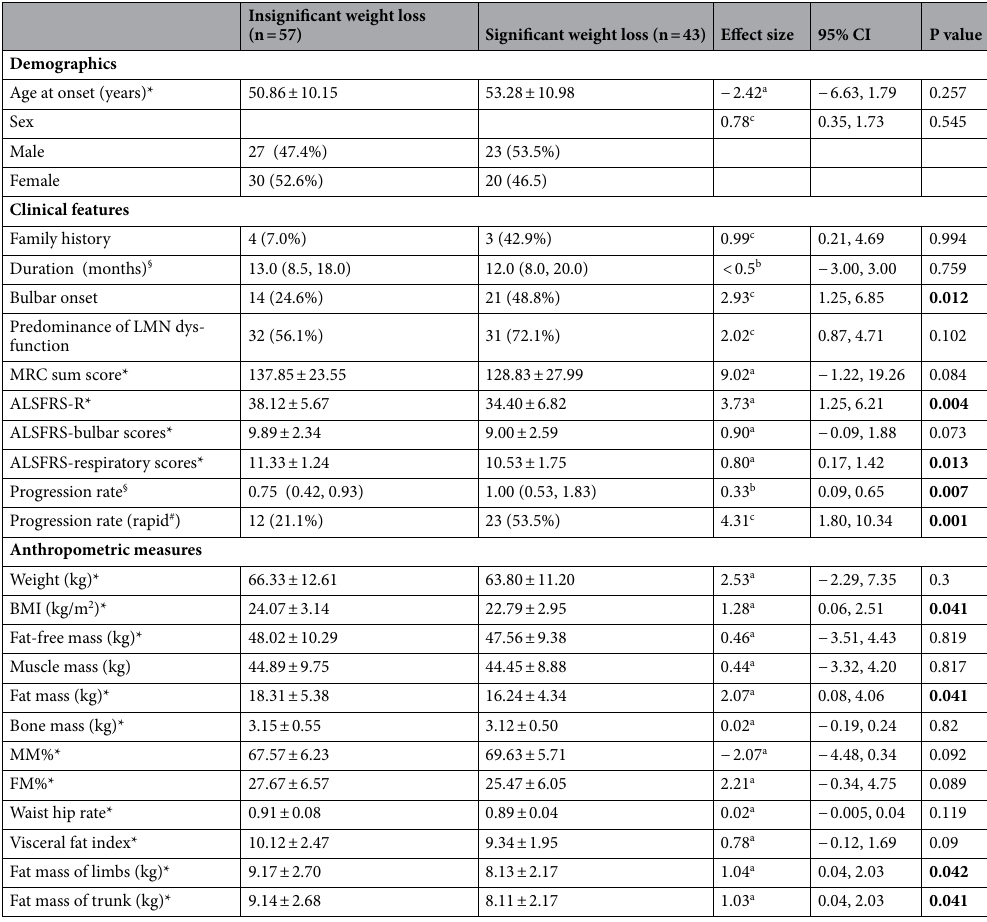
Table 2. Demographic, anthropometric and clinical features in different groups stratified by weight changes. *Data presented as mean ± standard deviation. § Data presented as median(IQR). a Mean difference. b median difference. c Odd ratio. # Rapid disease progression defined as monthly decline of ALSFRS score exceeding 1 score. LMN lower motor neuron, MRC Medical Research Council, ALSFRS-R revised ALS Functional Rating Scale, BMI Body Mass Index, MM% proportion of muscle mass, FM% proportion of fat mass. P-value < 0.05 is shown in bold.